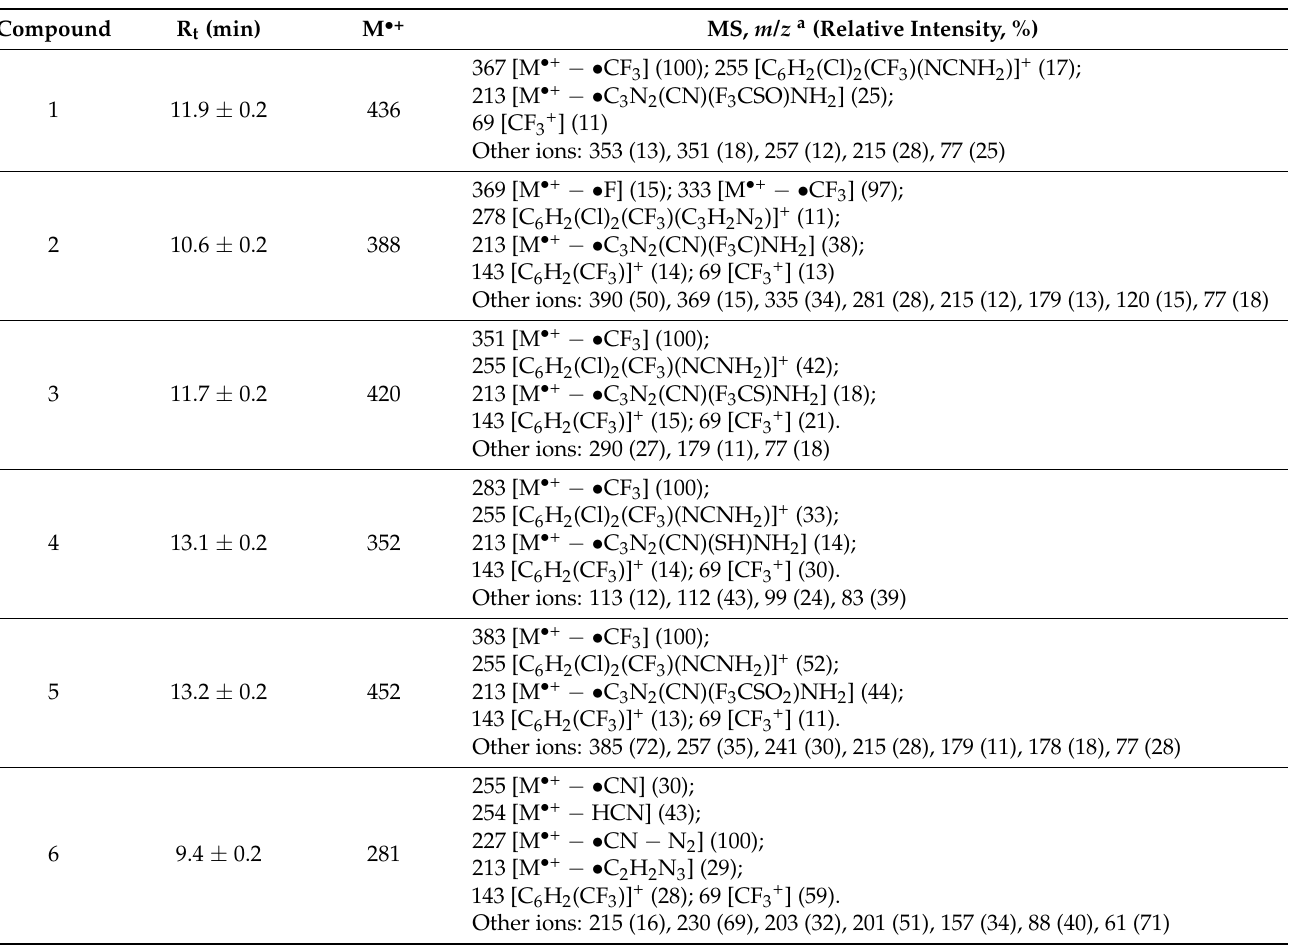
Figure 16. Chemical structures of the products from the photodegradation of fipronil identified in this study. Fipronil–sulfide ( 3 ), 4-thiol–fipronil ( 4 ), fipronil–sulfone ( 5 ), and 2-[2-(2,6-dichloro-4-(trifluoromethyl) phenyl) diazenyl] acetonitrile ( 6 ). Table 5. GC retention times (Rt) and mass spectral data (EI-MS) for fipronil (1) and the degradation products 2-6.